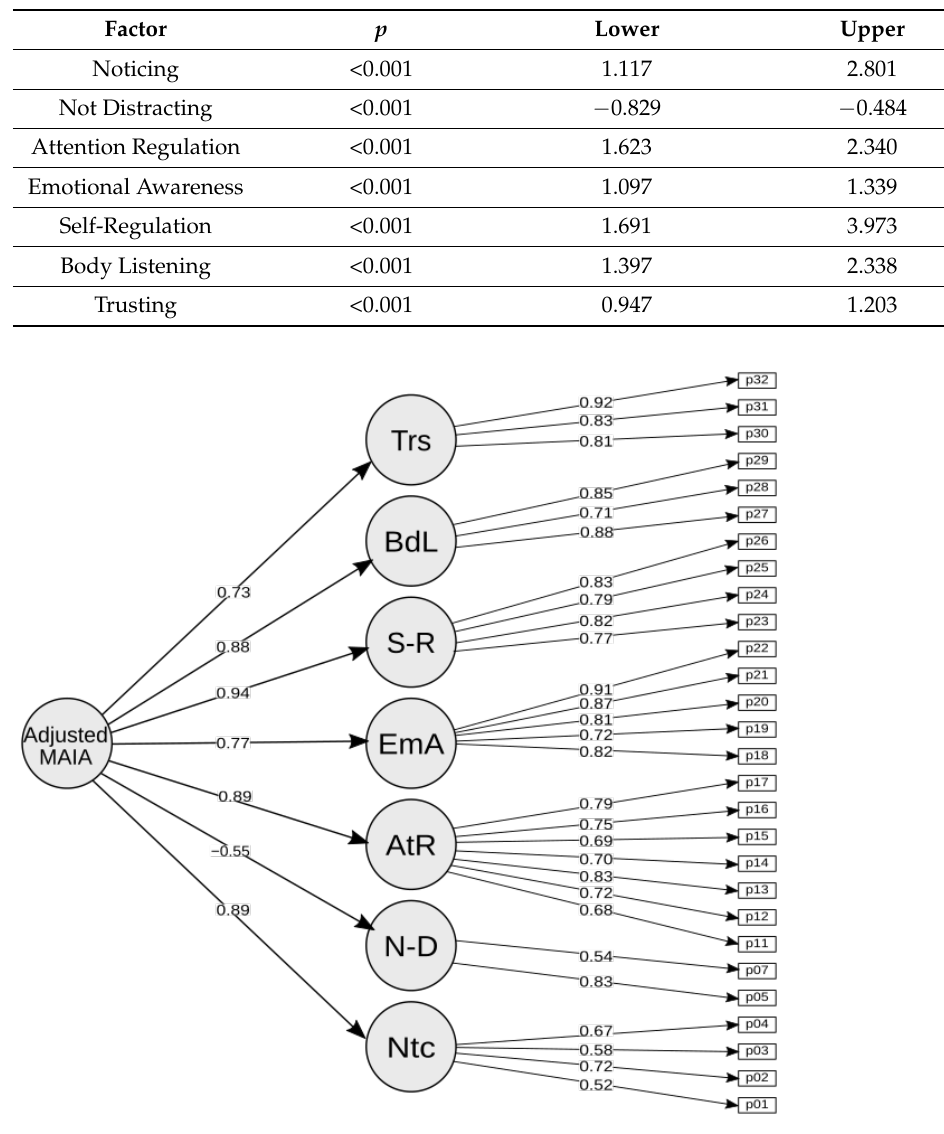
Figure 1. Proposed seven-factor